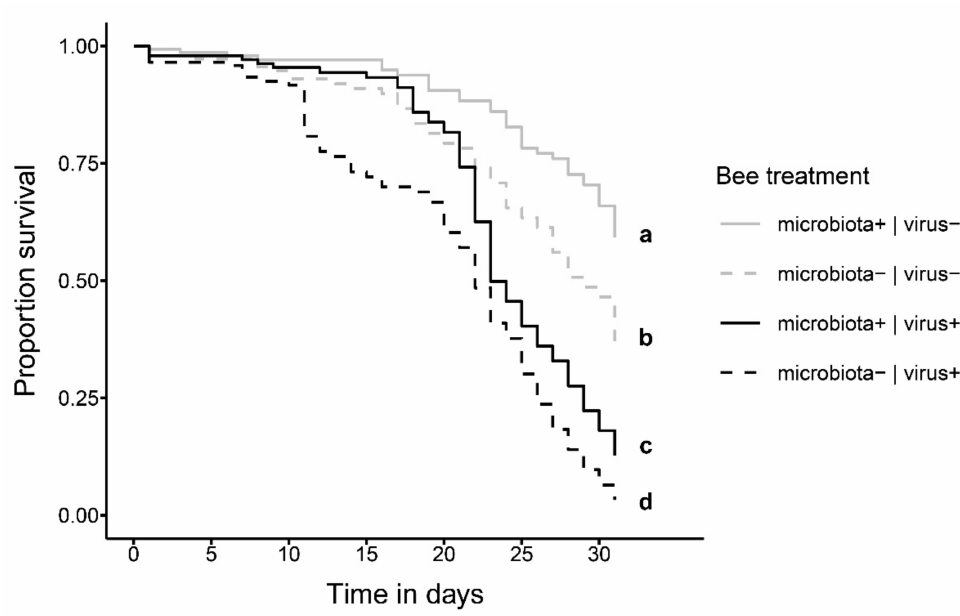
Figure 2. Survival of bees shown as Kaplan–Meier estimates over the course of the experiment (31 days) that were either fed a bee hindgut homogenate to establish the gut microbiota (microbiota+, solid lines) or not (microbiota − , dashed lines) at day 1 of adult emergence and were then either fed a DWV-B virus inoculum (virus+, black lines) or not (virus − , gray lines) at day 6 of the experiment. Small letters indicate statistically significant differences at α = 0.05 in a Cox mixed-effects model. Irrespective of whether or not the normal gut microbiota was established in bees, feeding of DWV-B virus to bees resulted in similar, high viral titers in microbiota+|virus+ and microbiota − |virus+ bees at day 11 of the experiment (Figure 3; Table S5; LMM, LR-test, χ 2 = 0.136, df = 1, p = 0.712). Experimental bees that were not fed the virus showed only a low background infection, especially bees originating from source colony G1. Viral titer did not differ statistically in microbiota+|virus − and microbiota − |virus − bees (Figure 2, b; Table S4; LMM, LR-test, χ 2 = 3.270, df = 1, p =